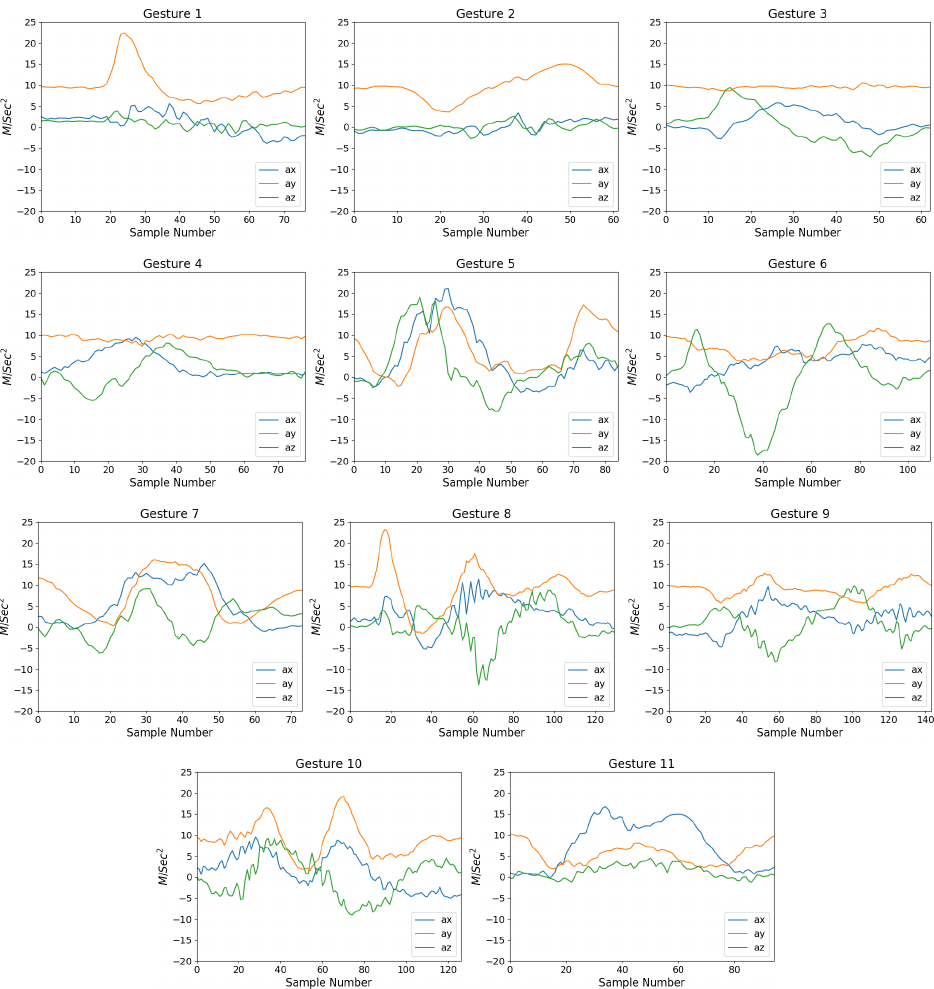
Figure 14. Samples of waveforms produced by accelerometers in three axes (gx, gy, and gz) for each